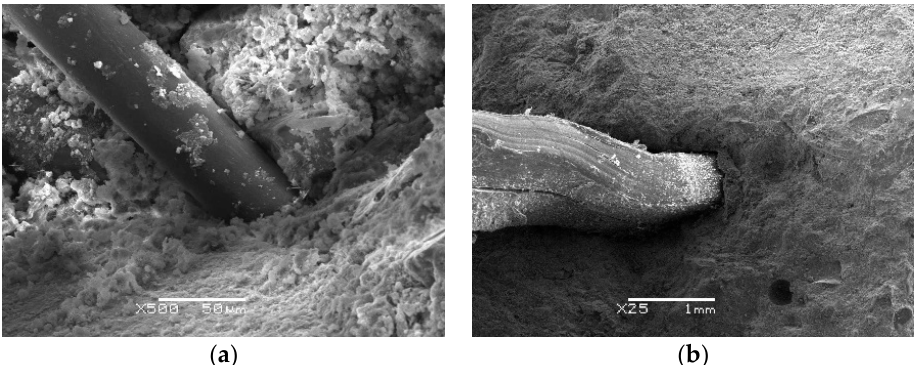
Figure 22. BF and SF distribution in concrete with w/c ratio of 0.54: ( a ) BF; ( b ) SF. Materials 2019 , 12 , x FOR PEER REVIEW